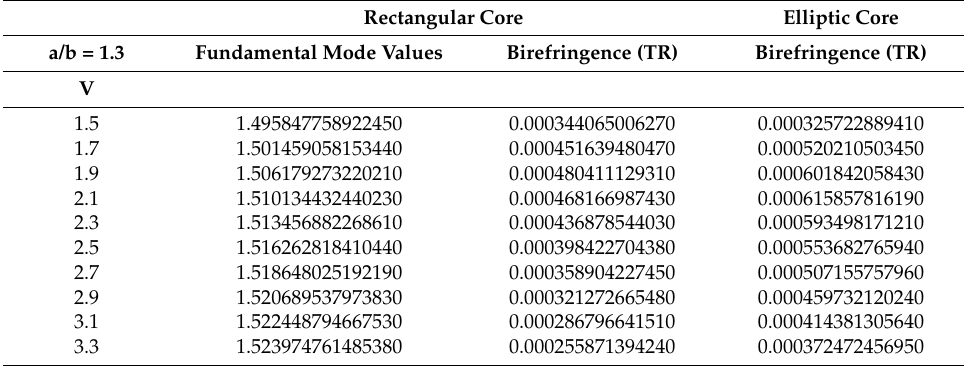
Table 6. Comparison of birefringence for elliptical and orthogonal core fibers.